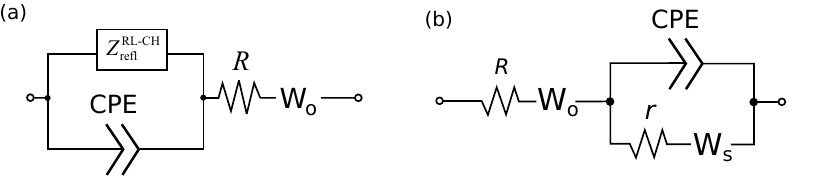
Figure 4. Equivalent circuit model of PANI-MWCNT pseudocapacitor with fractional phase-field element ( a ), and simplified model ( b ).